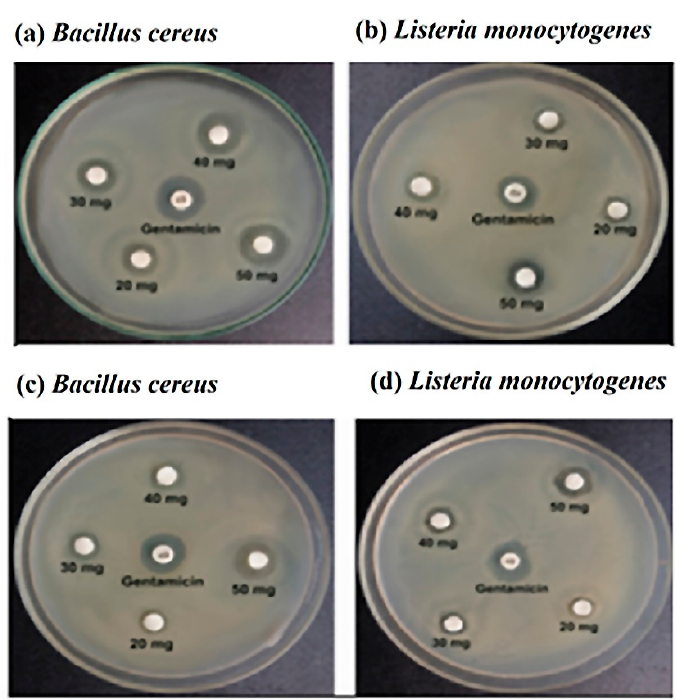
Figure 2. The zone of inhibition with stingless honey sample ( a , b ) and sting honey sample ( c , d ) against the Bacillus cereus and Listeria monocytogenes, respectively. Table 2. The antibiotic sensitivity test for the detection of the resistance pattern of Bacillus cereus and Listeria monocytogenes.